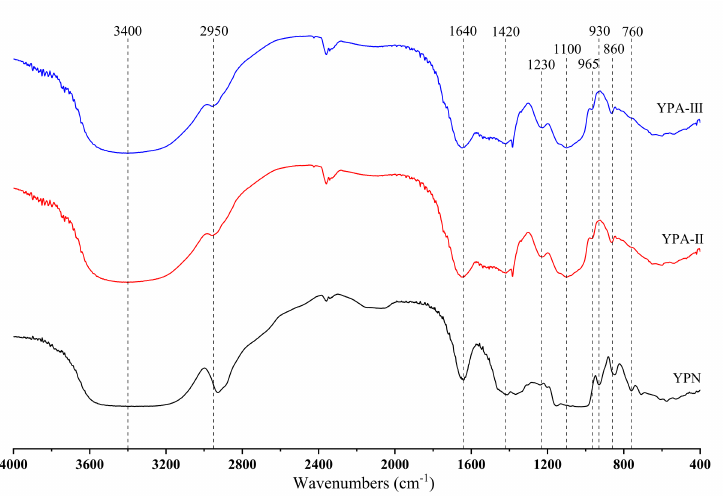
Figure 6. FT-IR spectrum of yam polysaccharide